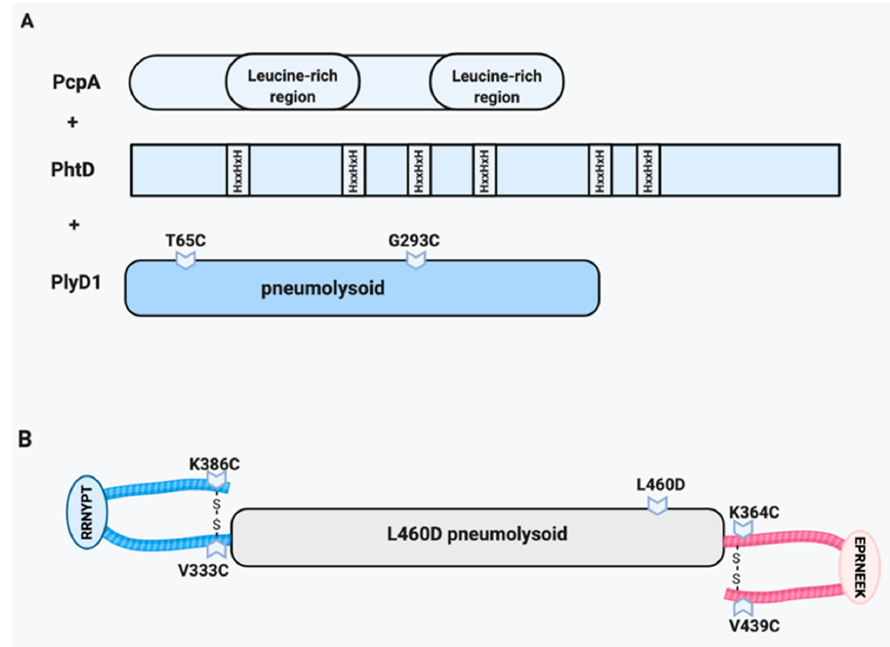
Figure 3. Multivalent protein formulations . ( A ) The PcpA, PhtD, PlyD1 multivalent vaccine con- sisting of recombinant PcpA and PhtD along with the PlyD1 pneumolysin toxoid. ( B ) YLN hybrid construct consisting of the YPT and NEEK conserved domains of CbpA fused with the N- and C-teriminus, respectively, of the inactive L460D pneumolysin toxoid. 6.1. PcpA/PhtD/pneumolysin toxoid multivalent vaccine.